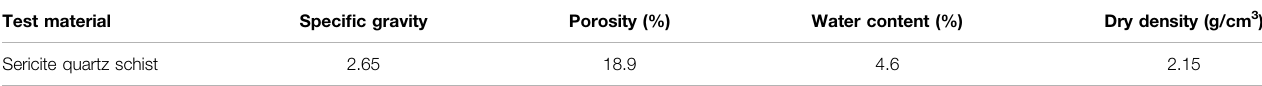
TABLE 1 | Indexes of basic properties of samples.